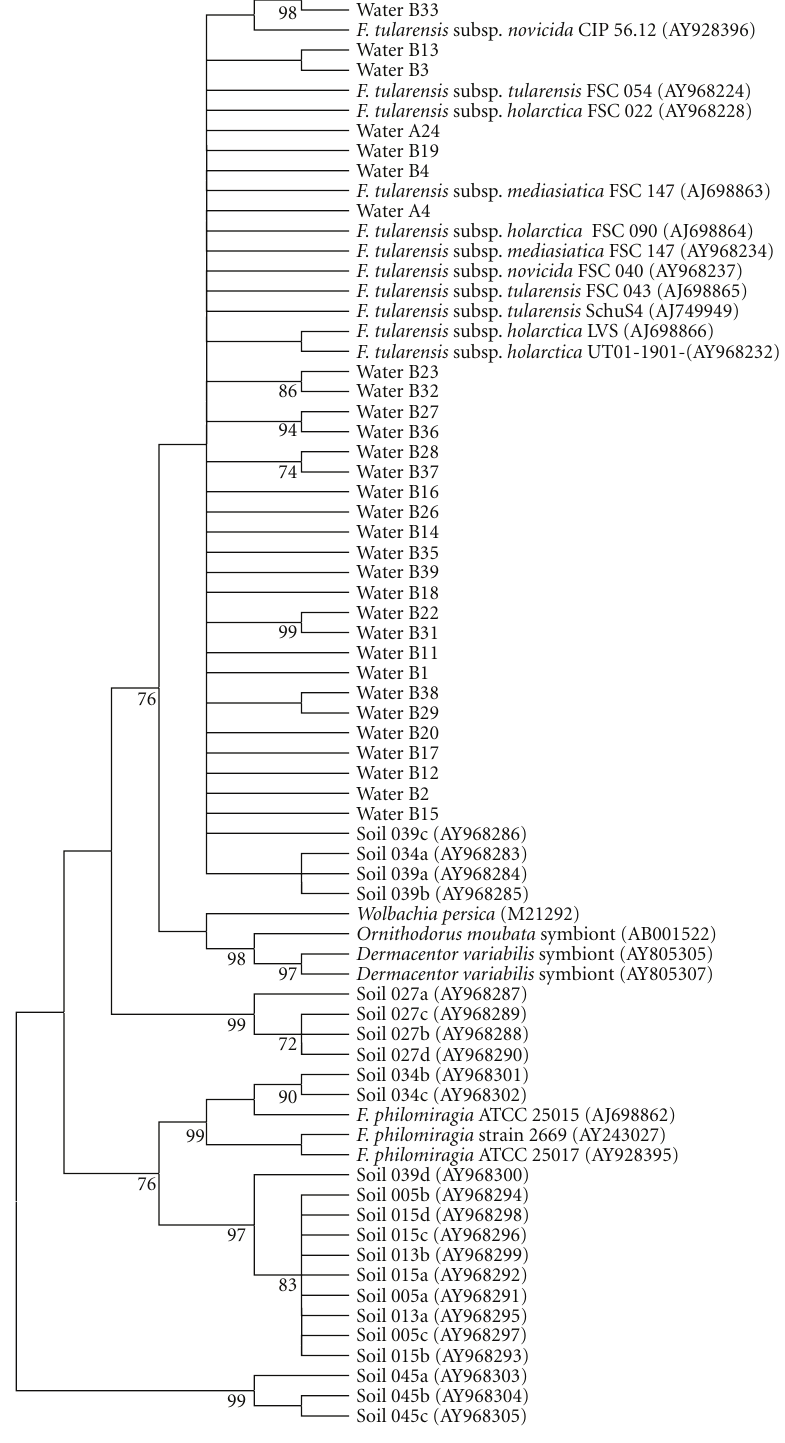
Figure 4: Phylogenetic analysis based on Francisella 16S rRNA sequences obtained from water samples in ¨Orebro (Water A/B, this study), environmental soil samples [6] and reference sequences from GenBank. The samples are named according to the sampling points, ¨Orebro A and B (Figure 1). Analysis was performed using maximum